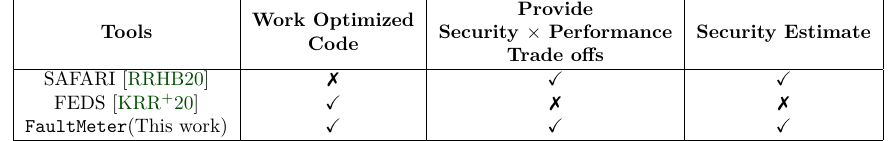
Table 2: Comparison with automated fault attack countermeasure insertion tools. Unlike the other tools, only FaultMeter can work with optimized code and tune the countermeasure to trade off between performance and